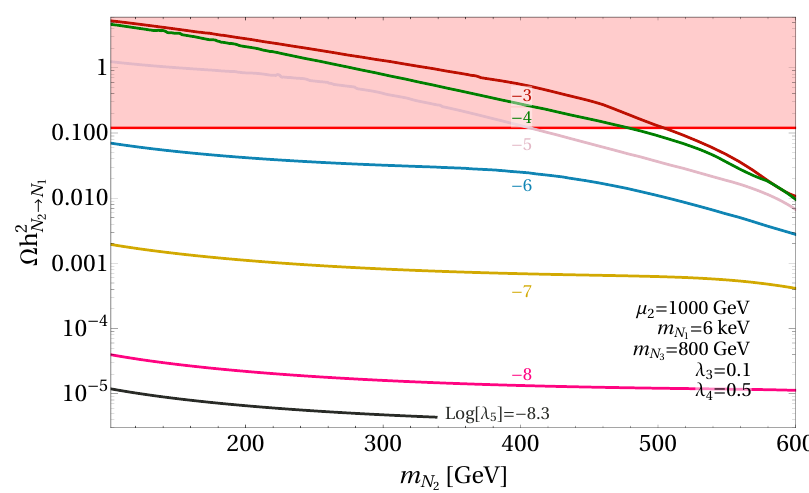
Figure 3. (cid:10) h 2 for di(cid:11)erent choices of the coupling constant (cid:21) 5 . In general, larger values N 2 ! N 1 of this coupling lead to larger DM production from N 2 decays. Every parameter point in the red shaded region is overproducing DM and is thus ruled out. The truncation of the (cid:21) 5 = 10 (cid:0) 8 : 3 curve is due to the bounds from LFV